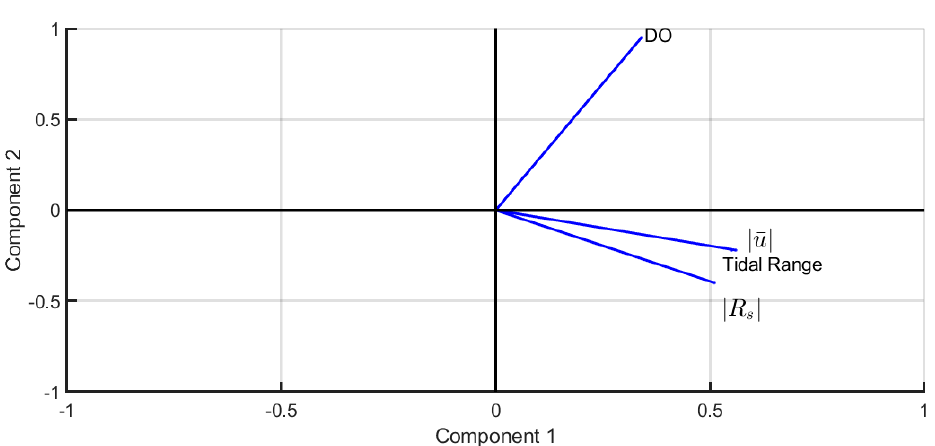
Figure 7. Bi-plot of principal components one and two resulting from a PCA on variables: current speed ( (cid:12) u (cid:12) ), Reynolds shear stress magnitude ( | R S | ), tidal range, and dissolved oxygen (DO). Blue lines represent loading of each variable onto each principle component. Principle component one and two represent 74% and 19% of the dataset variance, respectively.